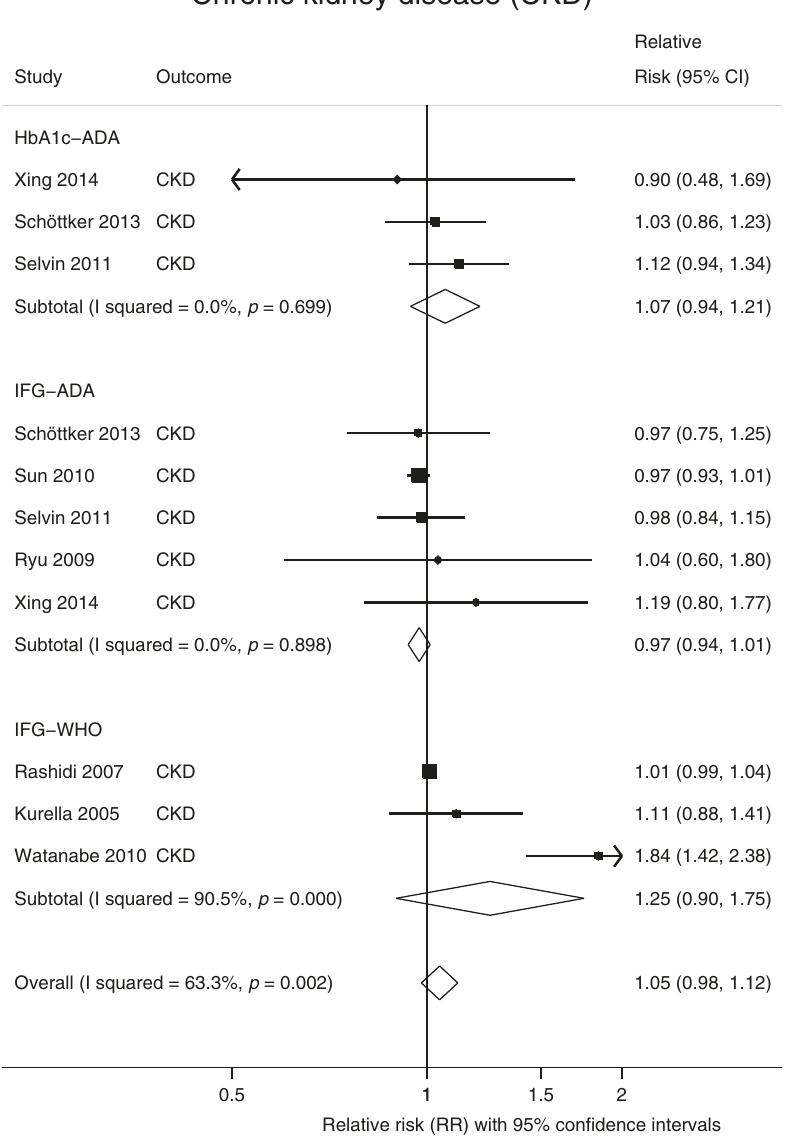
Table 2 Causal association between prediabetes only and risk of T2D.